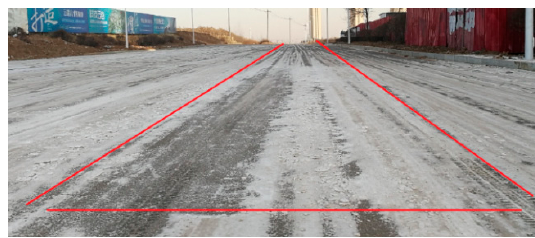
Figure 7. Snowy road driving experiment.